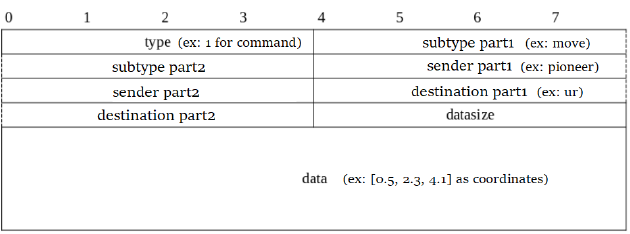
Figure 3. Message